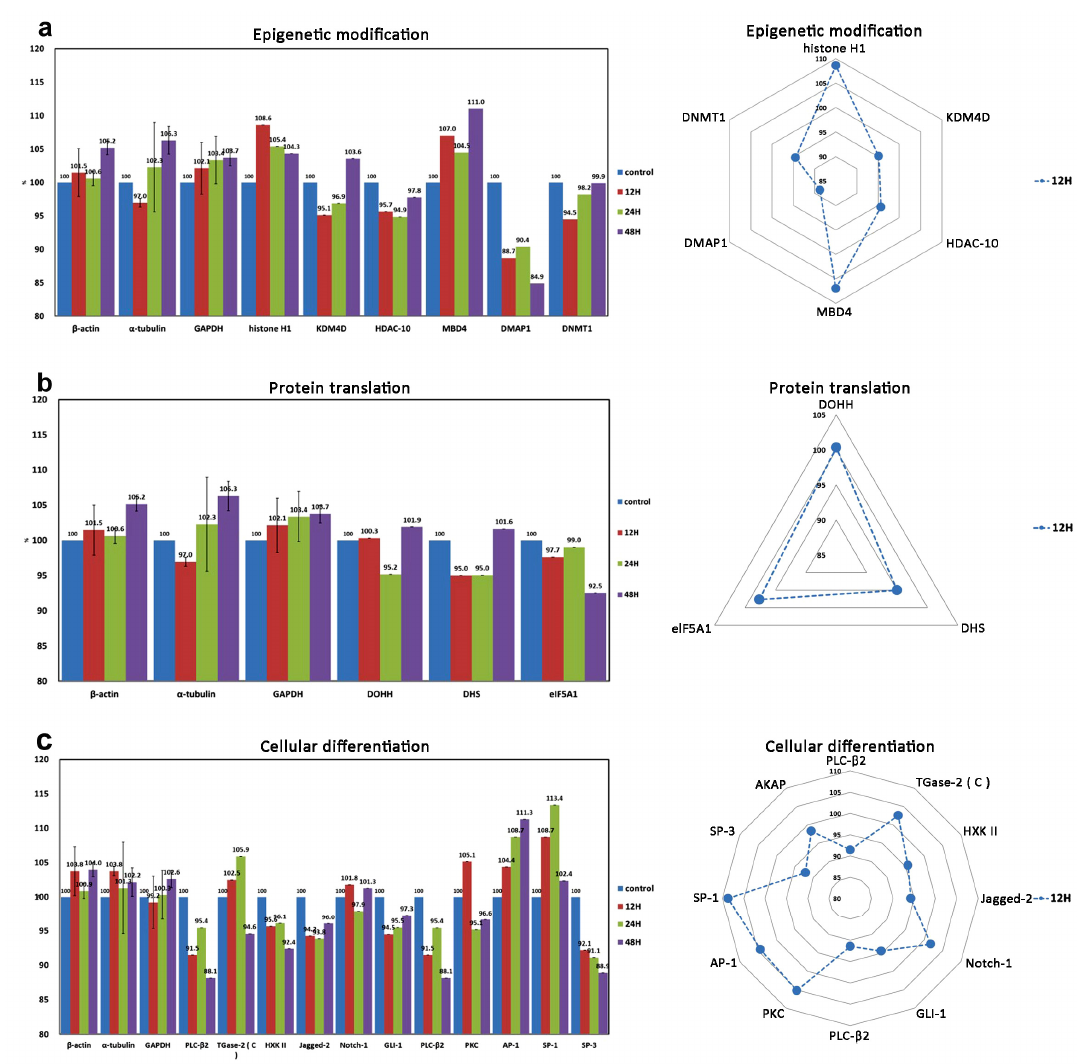
Figure 2. ( a ) Changes to epigenetic modification-related proteins after PTX treatment in RAW 264.7 cells; ( b ) changes to protein translation-related proteins after PTX treatment in RAW 264.7 cells; ( c ) changes in cellular differentiation-related proteins after PTX treatment in RAW 264.7 cells. Left-sided graph shows changes in protein expression according to the application time of PTX, blue bar; control group, red bar; 12 h treatment of PTX, green bar; 24 h treatment of PTX, purple bar; 48 h treatment of PTX. Right-sided polygonal graph shows protein expression profiles after 12 h treatment of PTX. (JPG 916